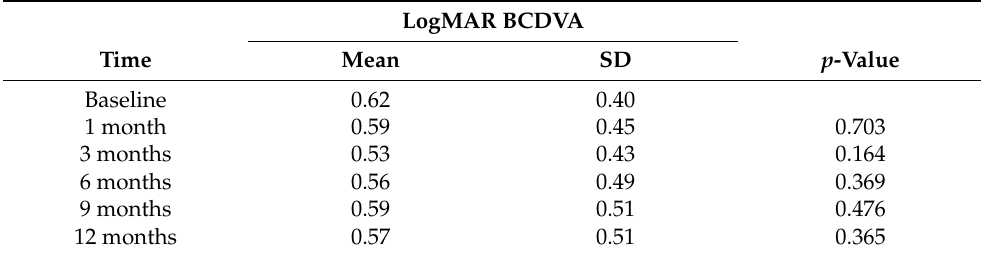
Table 4. BCDVA at various postoperative time points compared to the baseline.